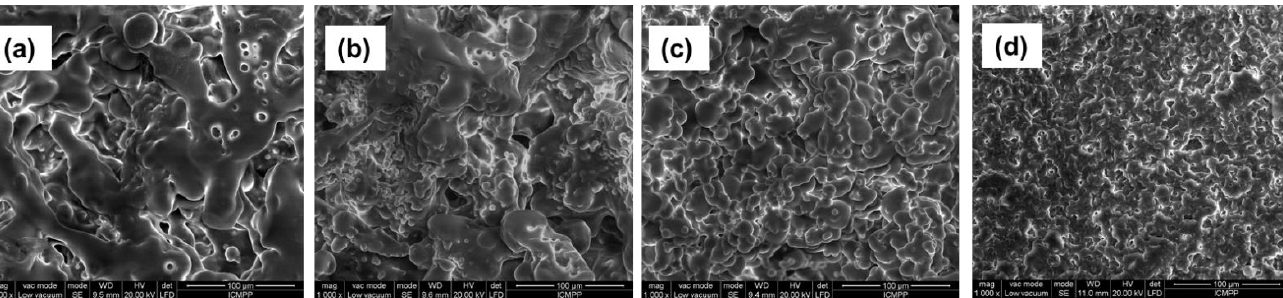
Figure 6. Influence of HEMA:P4VPB-1 ratio on the surface morphology of PHEMA/P4VPB-1 ( a ) 1:0.2, g/g; ( b ) 1:0.3, g/g; ( c ) 1:0.4, g/g; ( d ) 1:0.5,g/g (solvent of P4VPB-1 = ethanol:sodium bicarbonate (40:60, v / v ), HEMA:TEGDMA = 1:50, mol/mol).